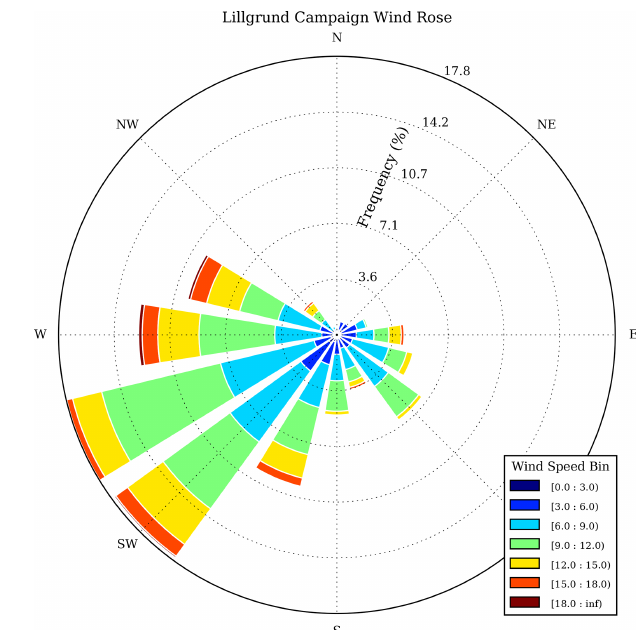
Figure 3. Wind rose depicting hub height wind speed and direction from the inflow measuring